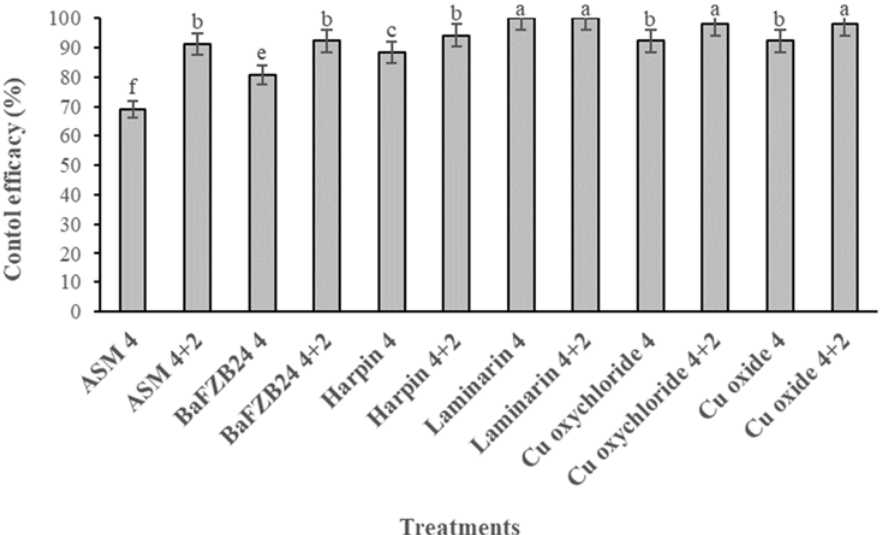
Figure 2. Control efficacy (%) of olive leaf spot achieved by several resistance-inducers, a biological control agent or copper fungicide treatments applied either in a single application 4 weeks before inoculation or in a dual application 4+2 weeks before the inoculation with Fusicladium oleagineum . Each value is the mean of three replicates ± standard error. Different letters on the columns indicate significant differences among treatments according to Tukey’s multiple range test at p = 0.05. Vertical lines indicate the standard error of the mean.